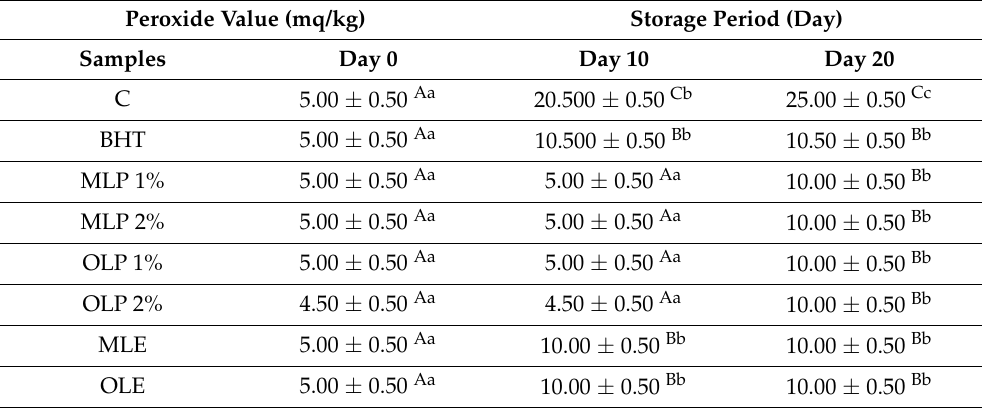
Table 4. The peroxide values of different chicken burgers, treated during refrigerated storage for 20 days, at 4 ◦